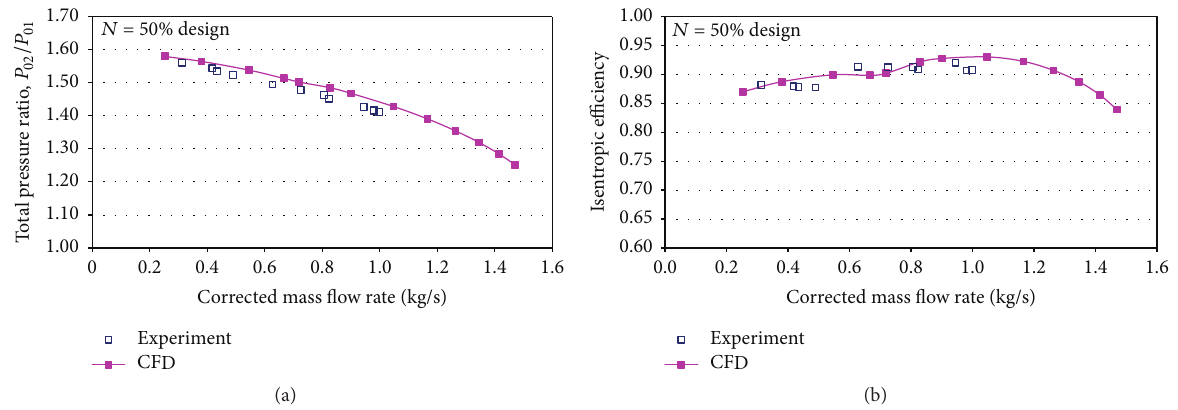
Figure 11: Validation study. Comparison of experimental and predicted performance of compressor without casing treatment at 50% design